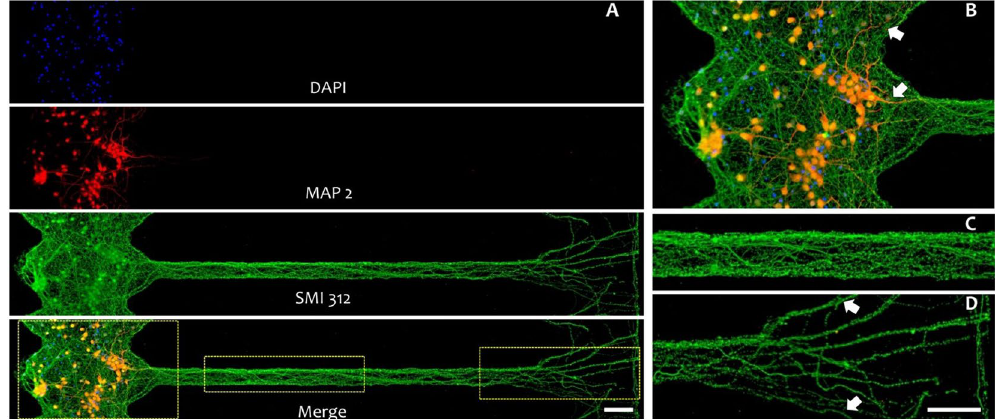
Figure 3. Immunofluorescence images from a cortical culture in a PDMS device on a glass coverslip at 10 DIV. ( A ) Somal reservoir (left), microchannel and counterpart reservoir (right); top to bottom: nuclei (DAPI, blue), somata and dendrites (MAP2, red), axons (SMI 312, green) and merged image. ( B – D ) Magnified view of merged image in A (yellow rectangles) showing a reservoir module with dendrites extending into the axonal diodes (white arrows), complex axonal bundle morphology inside the microchannel and branched-out axonal projections at the releasing point to the counterpart reservoir (white arrows). Scale bars: 30 µ m. The overall culture with 8 reservoir modules and microchannels is shown in Suppl. Fig.